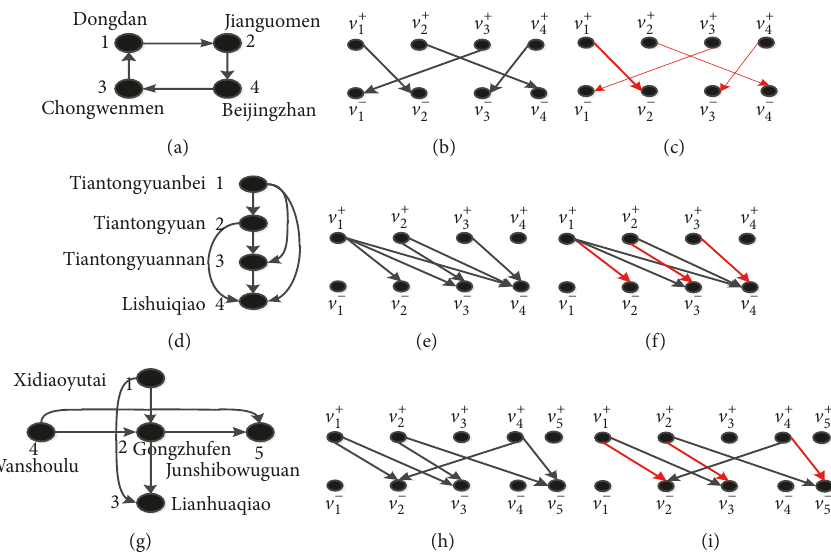
Figure 4: Example of method for determining the controllability of the local passenger flow network.